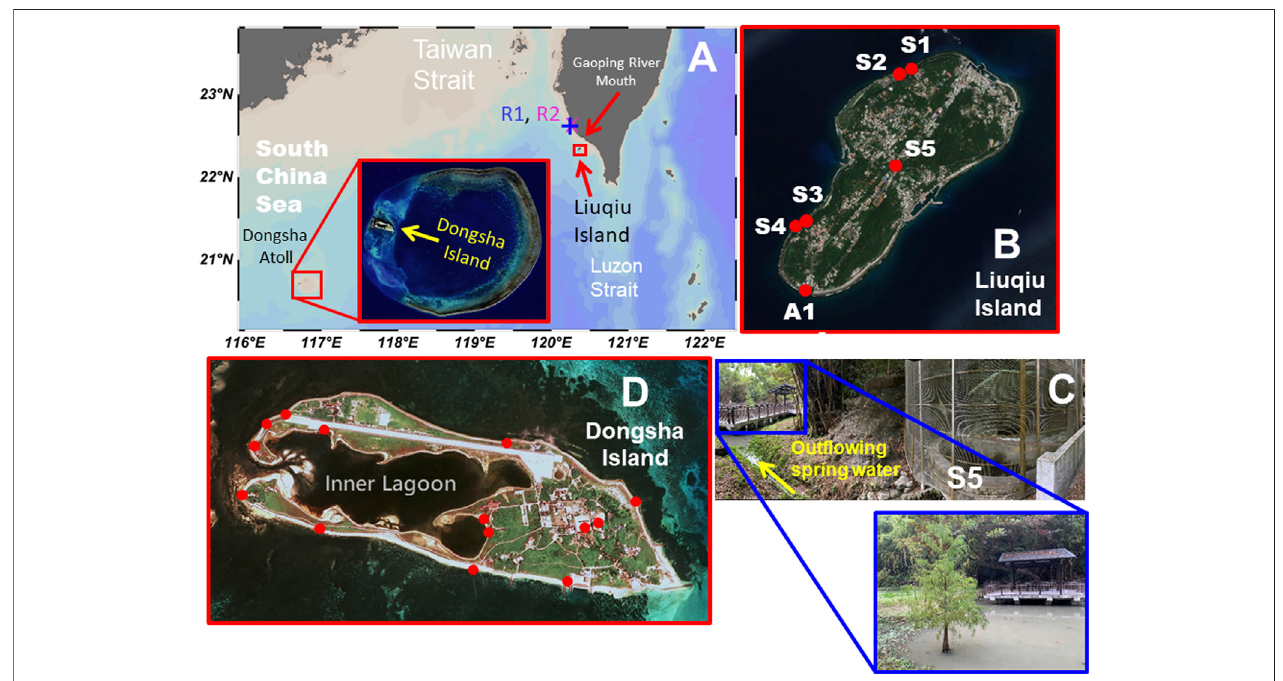
FIGURE1|(A) Studyareasandsamplinglocationsof (B,C) LiuqiuIslandand (D) DongshaIsland.ThesatelliteimageofDongshaAtollwastakenfromtheNational Geospatial-Intelligence Agency of the U.S. The maps were generated using Ocean Data View 5.0.0. Schlitzer, R., Ocean Data View, https://odv.awi.de, 2018.